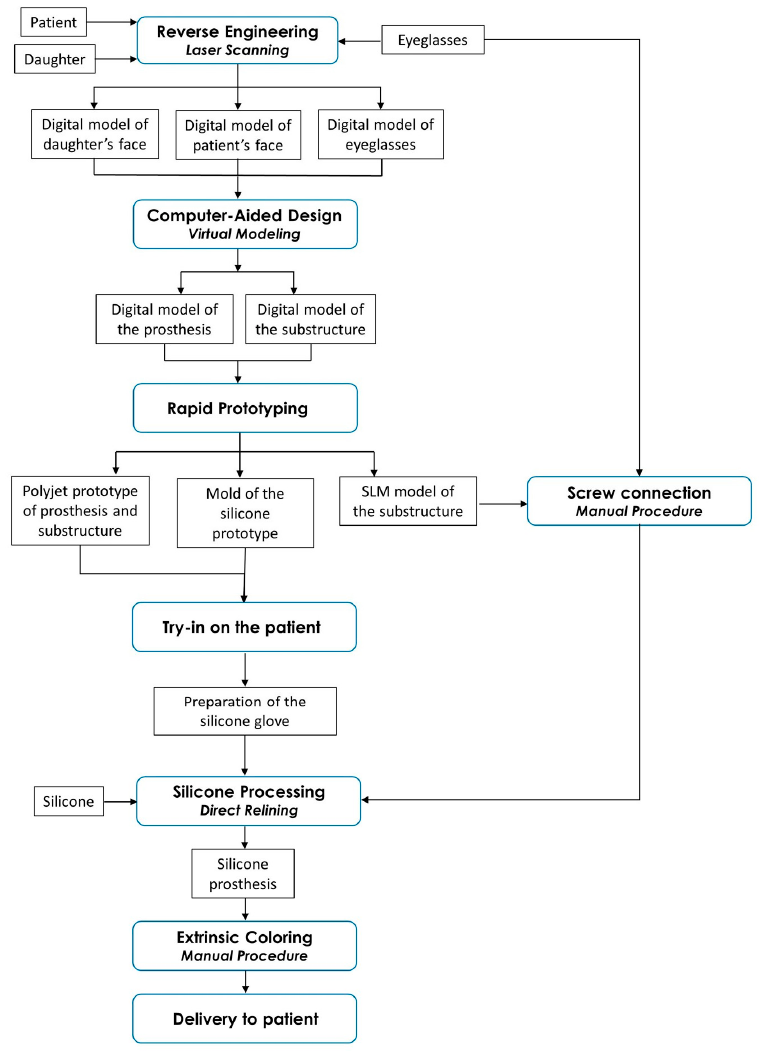
Figure 2. Graphic representation of the digital workflow used for the realization of the nasal–facial prosthesis.